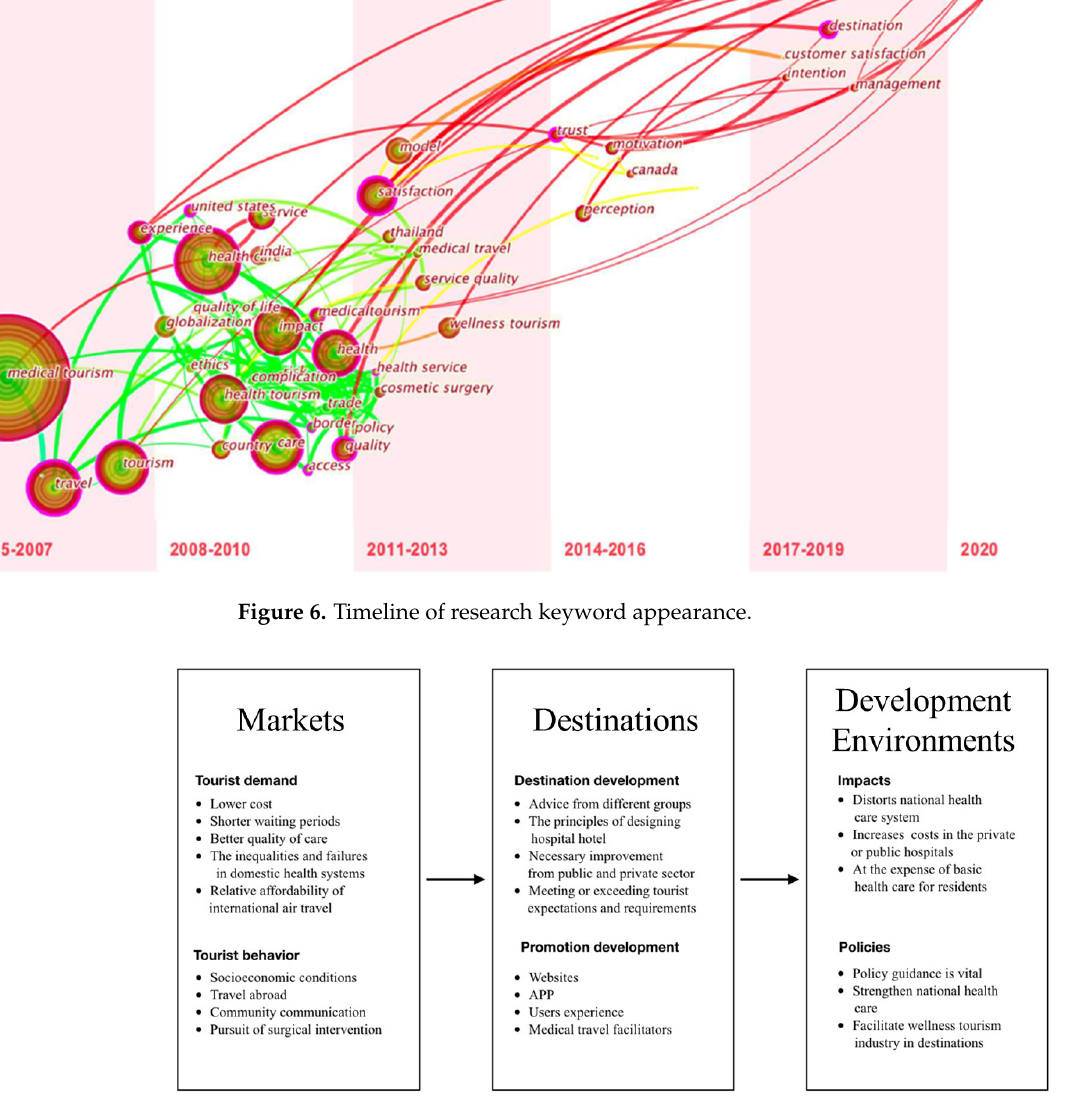
Figure 7. Themes of research articles.